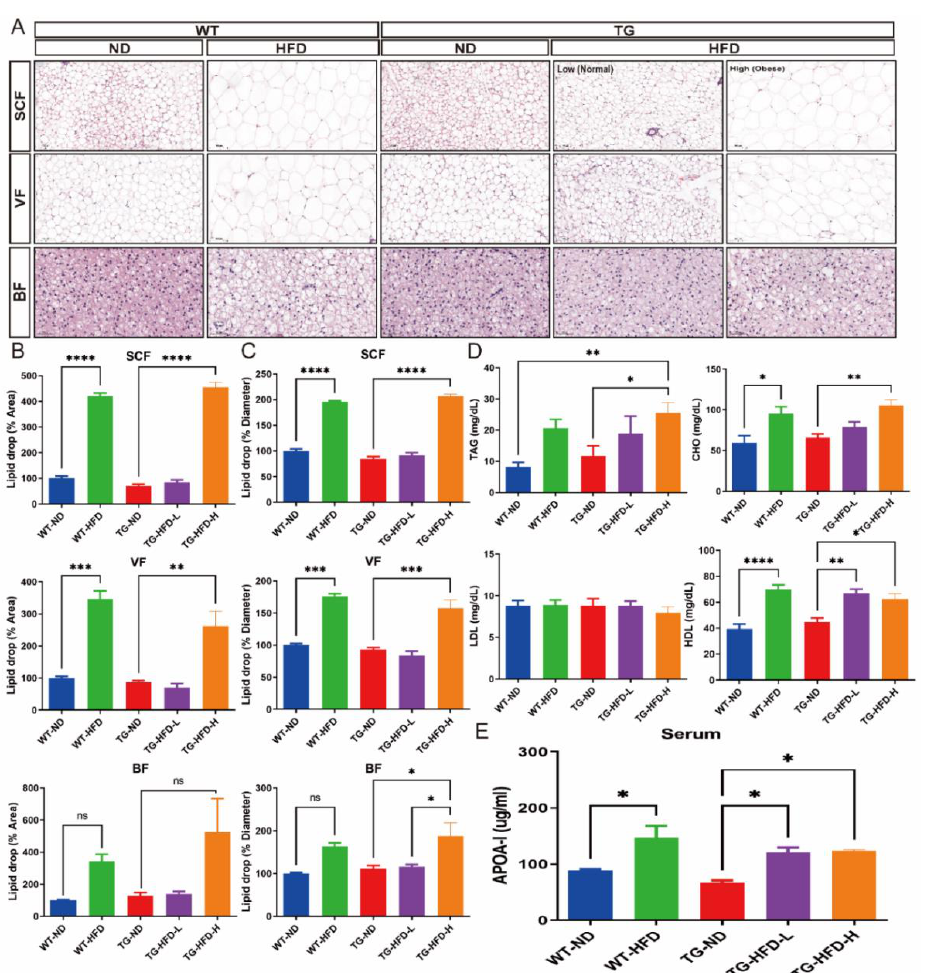
Figure 3. Analysis of fat pathology and blood cholesterol changes under a high-fat diet (HFD) in the 5XFAD Alzheimer’s disease transgenic mouse model. Represent images of subcutaneous fat (SCF), visceral fat (VF), and brown fat (BF) in female mice ( A ); quantitative estimation of the mean percent area of the lipid droplets in SCF ( B , top panel), VF ( B , middle panel), and BF ( B , bottom panel); and quantitative estimation of the mean diameter area of the lipid droplets in SCF ( C , top panel), VF ( C , middle panel), and BF ( C , bottom panel). Blood analysis of triacylglycerol, cholesterol, low-density lipoprotein, and high-density lipoprotein ( D ). Enzyme-linked immunoassay analysis of the serum levels of apolipoprotein AI (APOA-I) ( E ). ns (not significant), * p < 0.05, ** p < 0.01, *** p < 0.001, and **** p < 0.0001 (one-way analysis of variance with Tukey post hoc analysis). Data are presented as the mean ± standard error of the mean. The number of mice in each group was 3 for the fat tissue analyses, 6–7 for the blood analyses, and 4 for the APOA-I measurement. ND, normal chow; WT, wildtype; TG